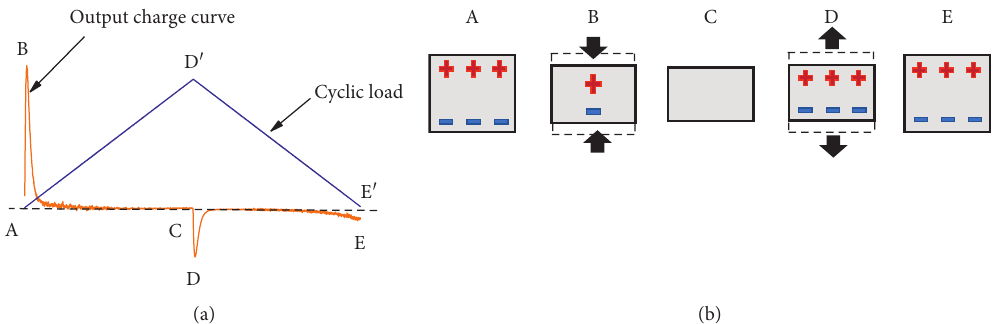
Figure 8: Diagram of piezoelectric effect under a triangle cyclic load. (a) The output charge induced by a cyclic load and (b) charges transferring due to applied uniaxial